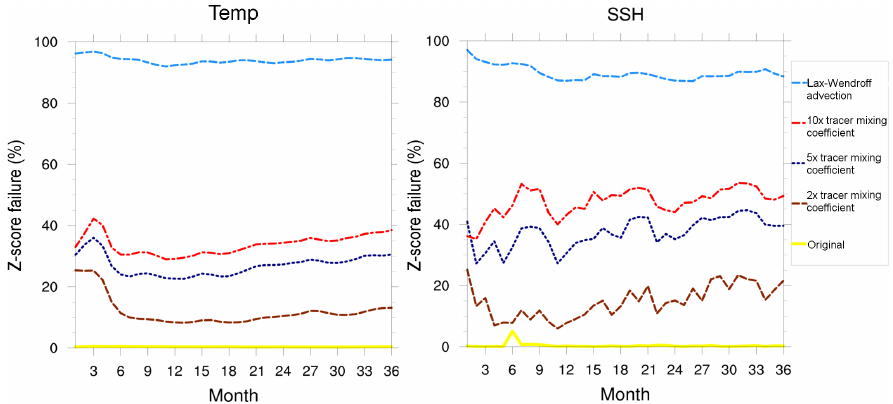
Figure 10. Percentage of grid points with Z -scores for temperature (TEMP) and sea surface height (SSH) that exceed the 3.0 threshold for simulations with an alternative tracer advection scheme (lw_lim) and several tracer mixing coefficients for convective instability.